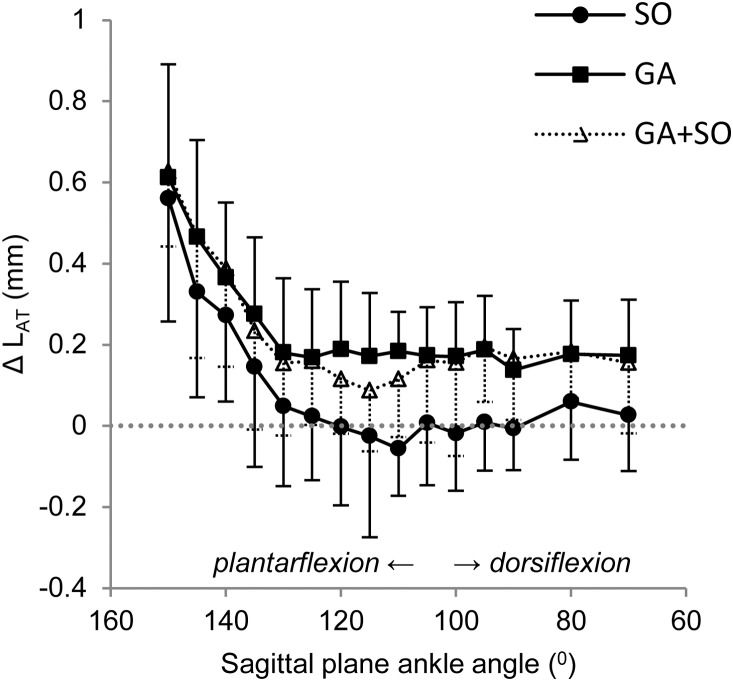
Effect of muscle activation on the length changes of the shared distal portion of the Achilles tendon.Changes in Achilles tendon length (ΔLAT) in response to simultaneous contraction of GA+SO (Δ), and to individual contraction of SO (•) and GA (▪) are plotted as a function of sagittal plane ankle angle. Knee angle was kept constant at 90°. Effects of ankle angle were found for SO, GA and GA+SO (p<0.001). Length changes due to SO contraction were lower than length changes due to GA (p = 0.033) and GA+SO (p = 0.028) contraction. No differences were found between GA and GA+SO contractions (p = 1.000). Means ± s.d. are shown (n = 10).